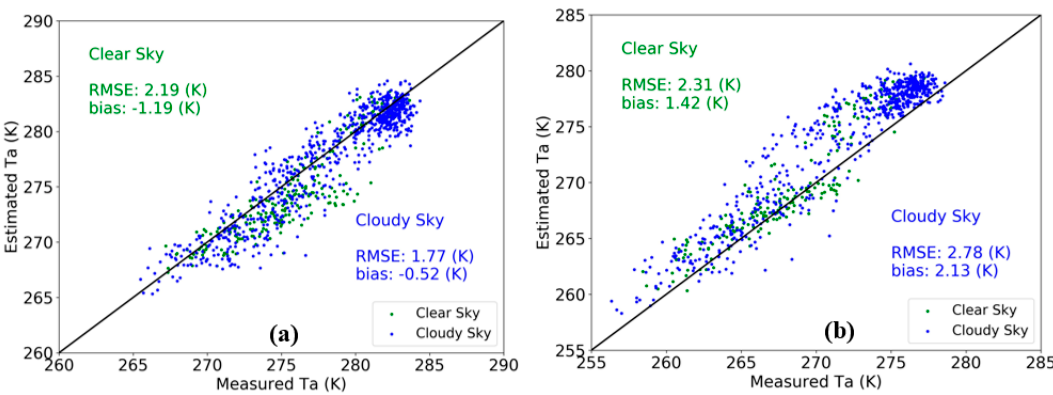
Figure 9. Scatter plot of the measured and PML estimated Ta under both clear and cloudy sky conditions for: ( a ) the Kyanging station; and ( b ) the Yala